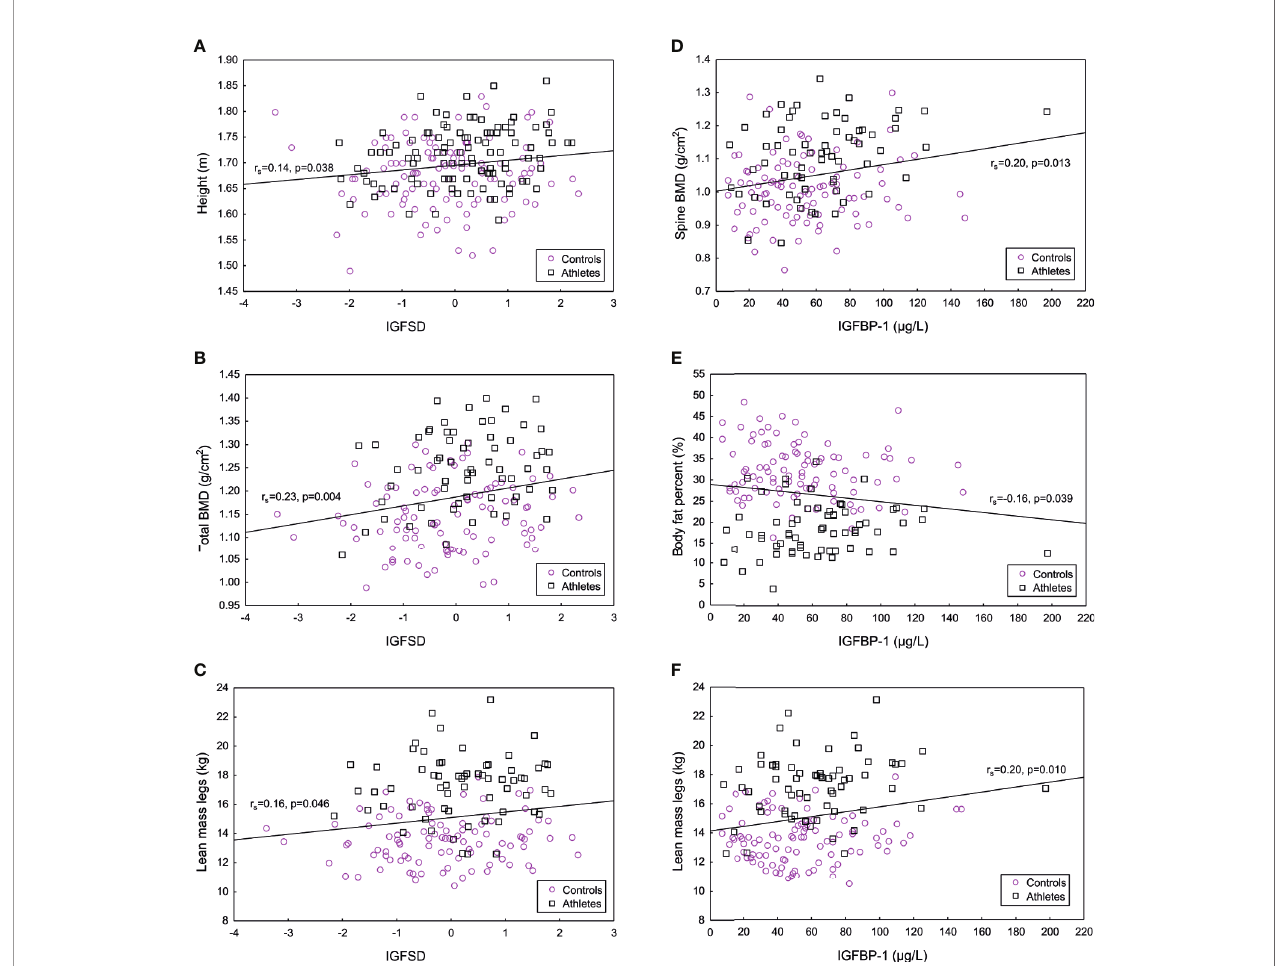
FIGURE 3 | Signi fi cant positive correlations between age adjusted insulin-like growth factor-I (IGFSD) and (A) height (m), (B) total bone mineral density (BMD) (g/cm 2 ) and (C) lean mass legs (kg), and signi fi cant correlations between IGF binding protein 1 (IGFBP-1) and (D) bone mineral density (BMD) spine (g/cm 2 ), (E) body fat percent (%) and (F) lean mass legs (kg) for athletes and controls combined. Magenta symbol representing controls and black symbol representing female Olympic